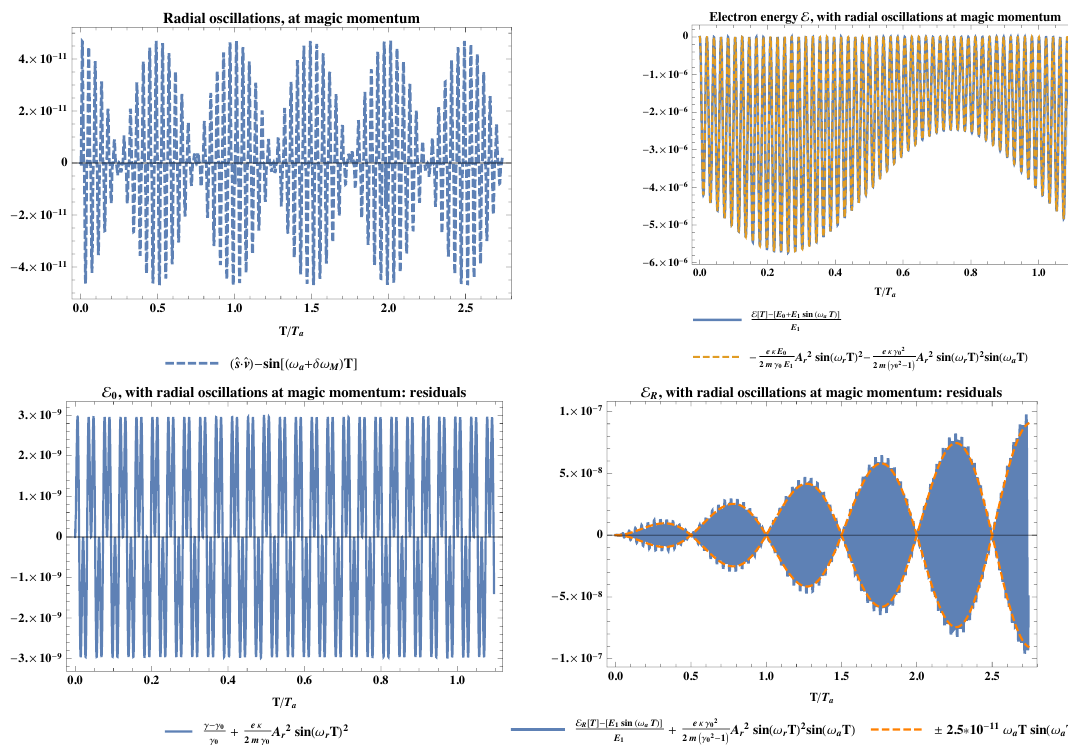
Figure 5 . We have solved numerically the equations of motion, with a radial displacement, and then evaluated ^ s (cid:1) ^ v = ((cid:6) (cid:1) v ) = ( (cid:13) j v jj S j ) and the electron energy E on the solution. We have used here x e = 0. The upper left plot shows ^ s (cid:1) ^ v , compared to a simple sinusoidal behavior: the best (cid:12)t shows a tiny o(cid:11)set (cid:14)! M (cid:25) 10 (cid:0) 11 ! a . The upper right plot shows the energy E , compared to a simple sinusoidal behavior E 0 + E 1 sin( ! a T ), where E 0 and E 1 are constants, and its residual. The bottom plots show the residuals, for E 0 and E R . A very small higher order residual is present for E R , which grows in time, signaling a tiny correction (cid:14)! to the frequency, since cos(( ! a + (cid:14)! ) T ) (cid:25) cos( ! a T ) (cid:0) T(cid:14)! sin( ! a t ). Here T a (cid:17) 2 (cid:25)=! a